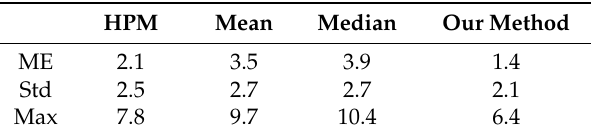
Table 2. Accuracy comparison between the four methods (unit: m). ME, Std, and Max represent mean error, standard deviation, and maximum error, respectively, between the measured and simulated plot-level maximum tree heights in the 30